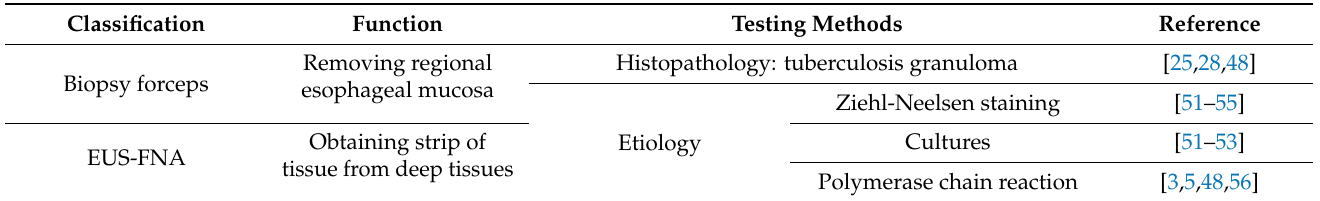
Table 3. Role of endoscopy in acquiring esophageal specimens and different testing